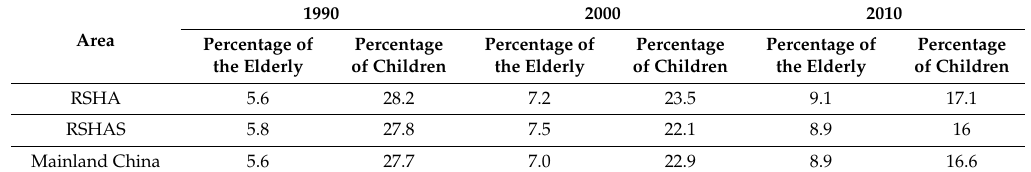
Table 2. The proportions of the total population that are vulnerable in different regions and years, unit: %.